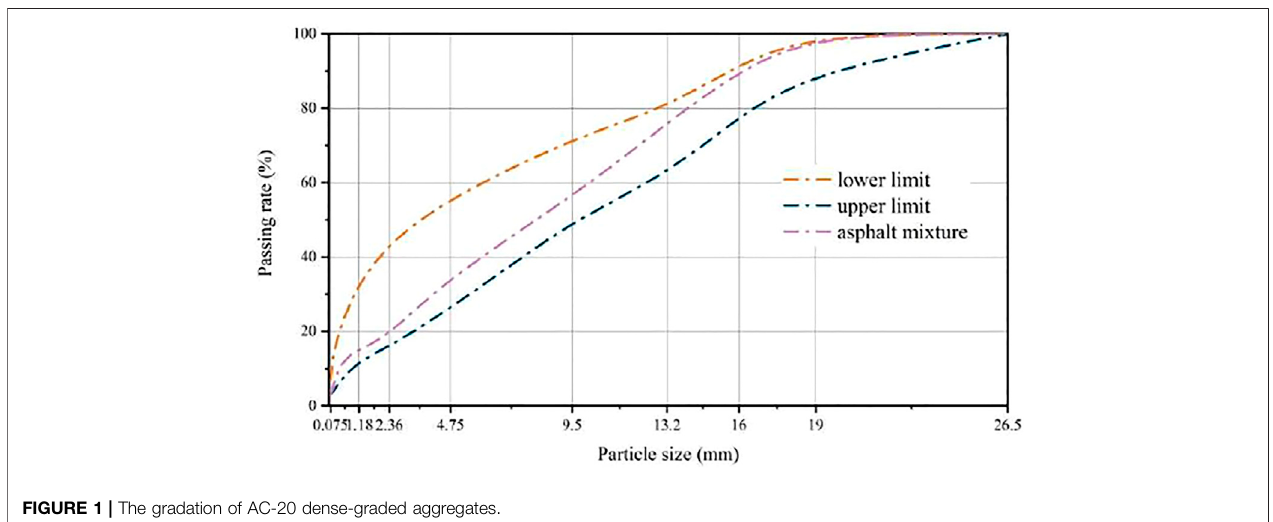
FIGURE 1 | The gradation of AC-20 dense-graded aggregates.